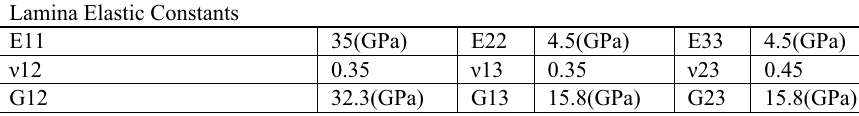
Table 1. The lamina elastic constants of GFRP.